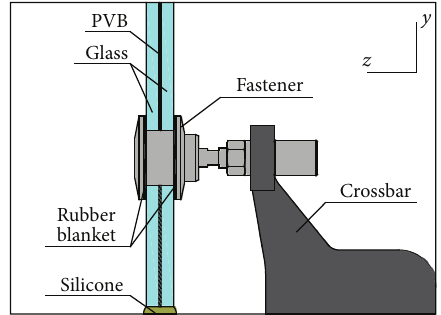
Figure 2: Four-hole rigid spider connector. Cross-section detail of point